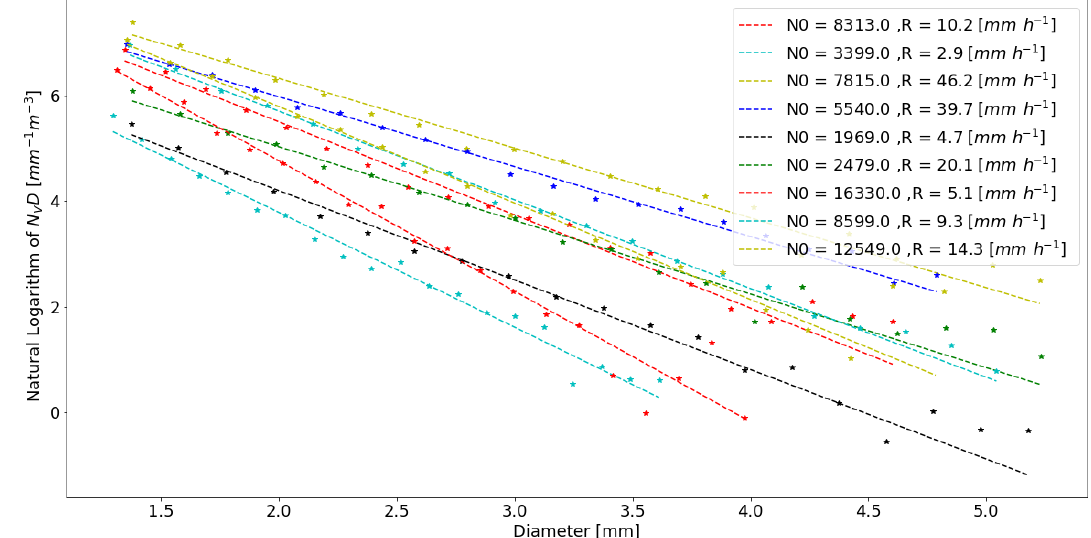
Figure 3. The natural logarithm of N V D is plotted against diameter ( D ) for different rainfall events as well as the linear line of best fit. Each rainfall event has a different value for N 0 within the observational period. Note that the data should not be extrapolated to the y axis as the x axis is truncated.